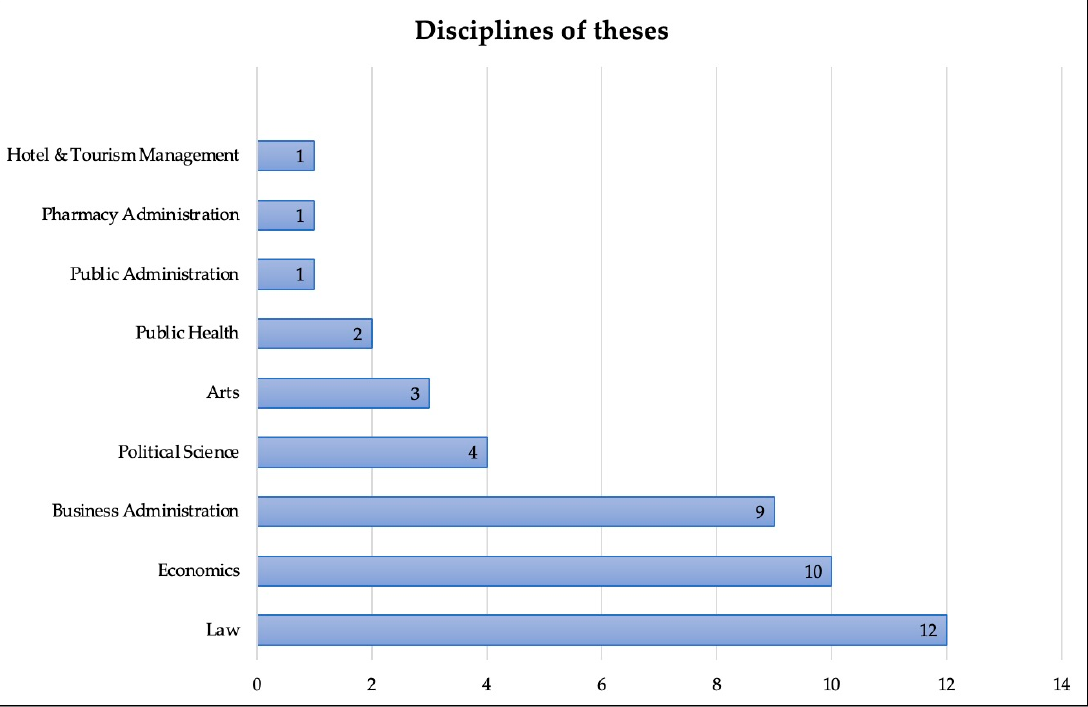
Figure 3. Disciplines of theses.